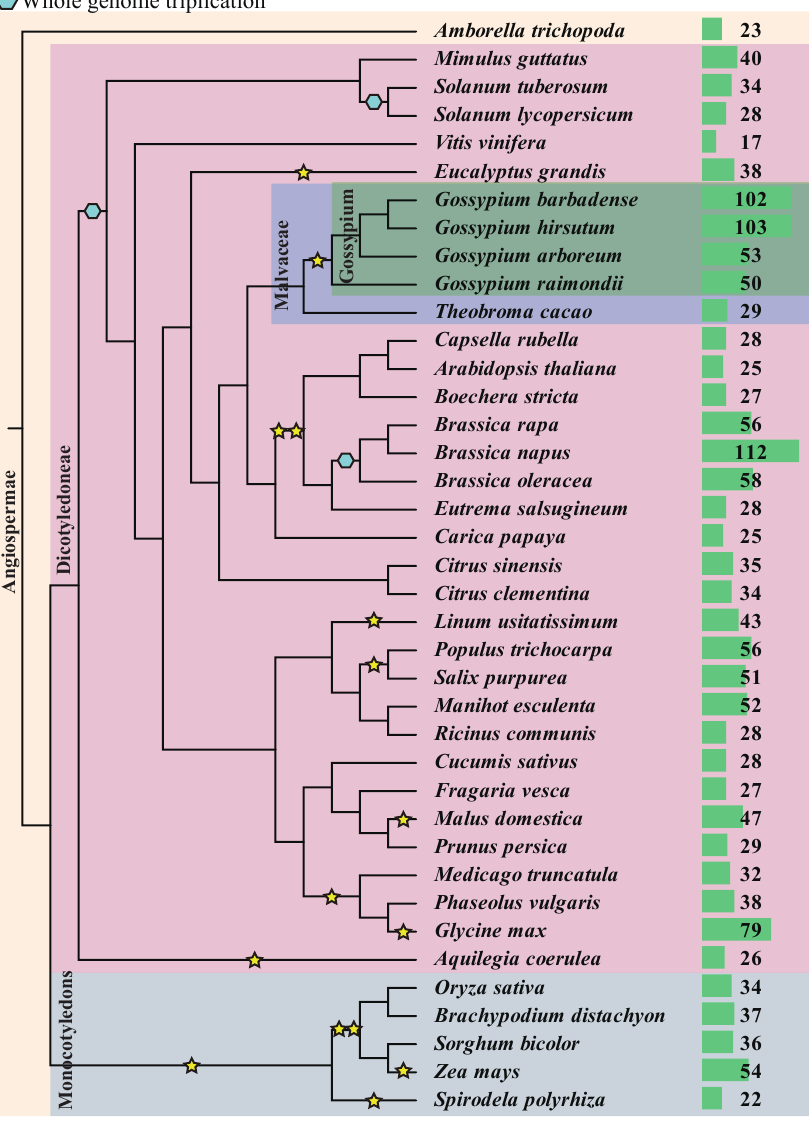
Figure 4. The phylogeny of 39 plants used in this study and the quantity of identified DUF4228 pro- teins. The right side shows the amount of DUF4228 protein detected in each plant. Whole genome duplication and whole genome triplication are represented by pentagram and hexagon symbols, respectively. The order of branch and divergence time was retrieved from the Timetree